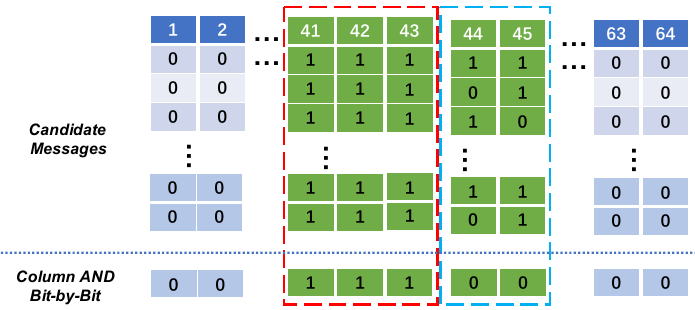
Figure 7. Column AND